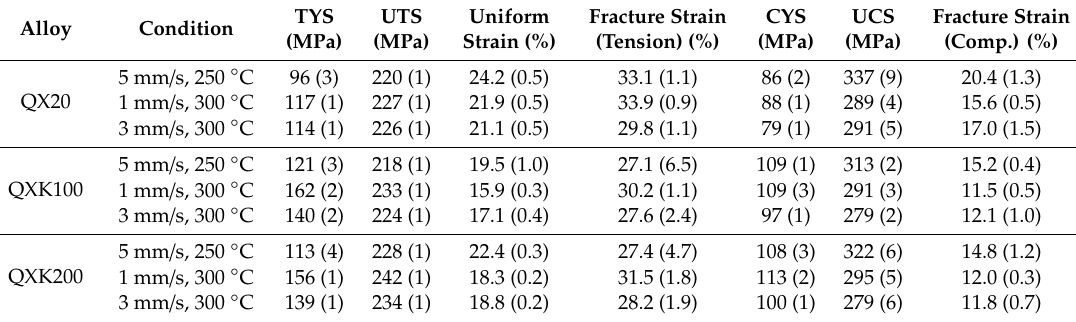
Table 5. Mechanical properties from tensile and compression tests in Figure 6 for the QX-series alloys. TYS: tensile yield stress, UTS: ultimate tensile stress, CYS: compressive yield stress, UCS: ultimate compressive stress; errors in